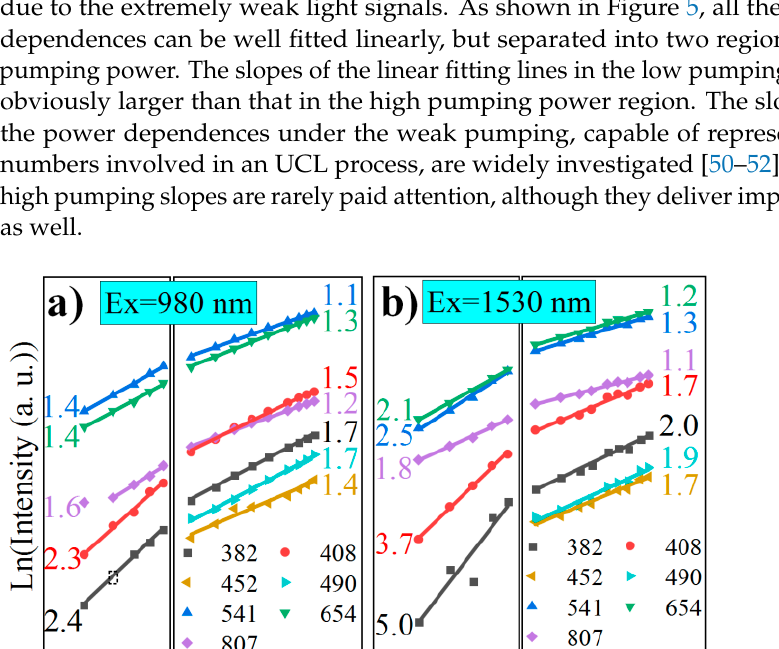
Figure 6. Simplified energy levels of Er 3+ with the dominant upconversion pathways upon ( a ) 980 nm excitation, ( b ) weak 1530 nm excitation, and ( c ) strong 1530 nm excitation.